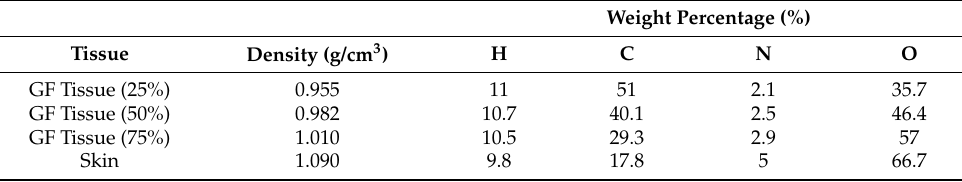
Table 1. Elemental properties and densities of the modelled breast layers [27].